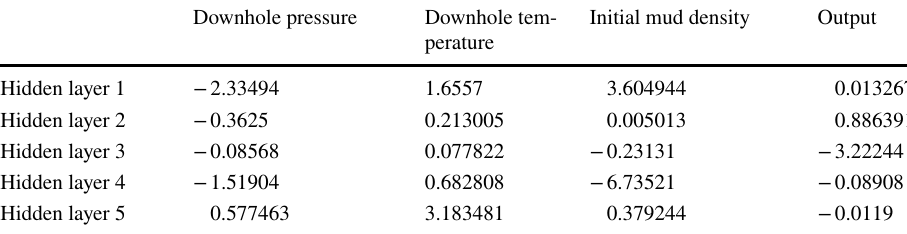
Table 8 Final connection weights